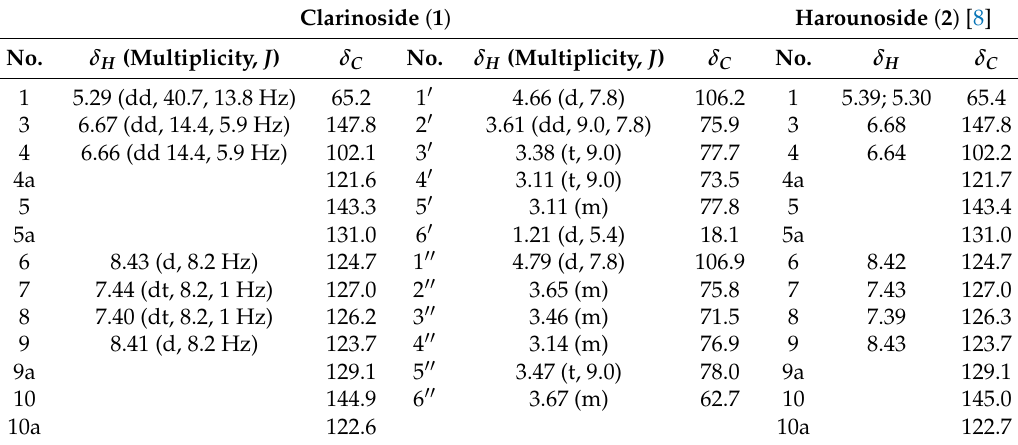
Table 1. 1 H and 13 C NMR data for 1 at 600 MHz in CD 3 OD ( δ H in